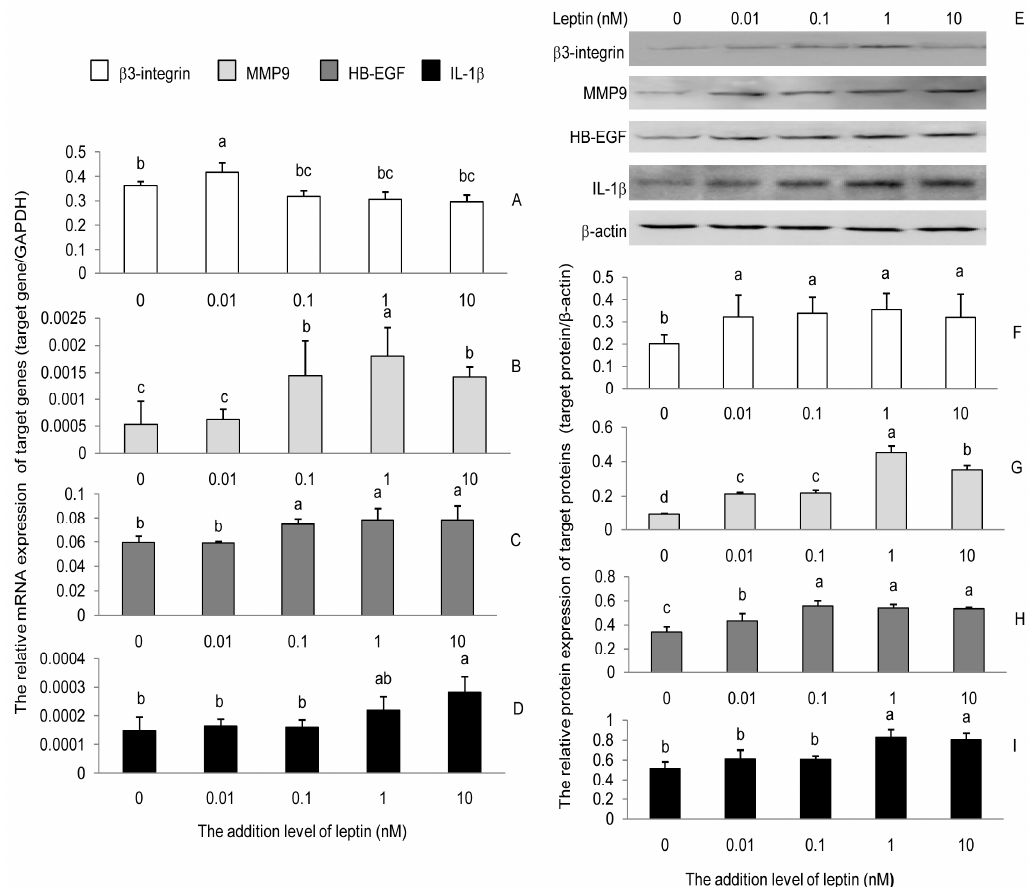
Figure 1. Expression of β 3-integrin, MMP9, HE-EGF, and IL-1 β mRNA and proteins in primary porcine endometrium epithelial cells (PEECs) in response to leptin. ( A – D ): The relative mRNA expression of β 3-integrin, MMP9, HE-EGF, and IL-1 β in response to leptin determined by RT-PCR. GAPDH was used as the internal control. ( E – I ): The relative protein expression of β 3-integrin, MMP9, HE-EGF, and IL-1 β in response to leptin determined by Western blot analysis (WB). β -actin was chosen as the loading control to normalize the target protein, and densitometric analysis of bands was carried out using ImageJ software. Columns with a di ff erent lowercase letter represent statistically significant di ff erences ( p < 0.05). Data (means ± standard error) are representative results derived from a minimum of three independent experiments.